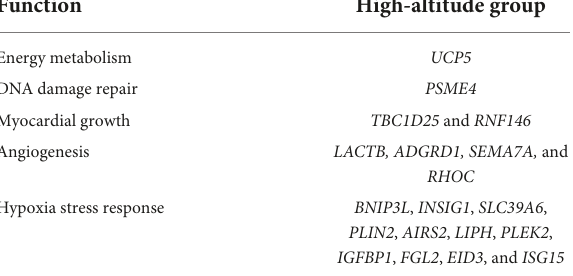
TABLE 4 HEGs related to high-altitude